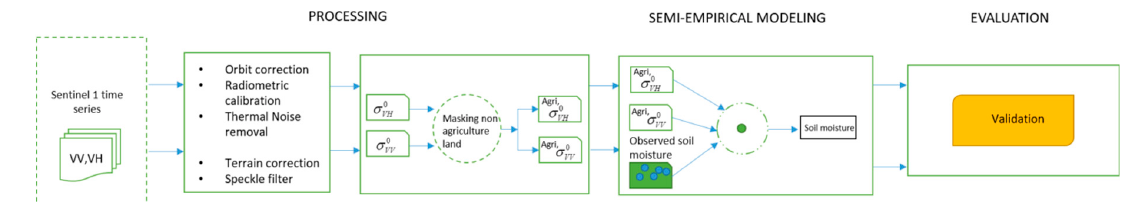
Figure 2. The process of estimating soil moisture using Sentinel-1 Co-Polarization (VV) and Cross-Polarization (VH) imagery.